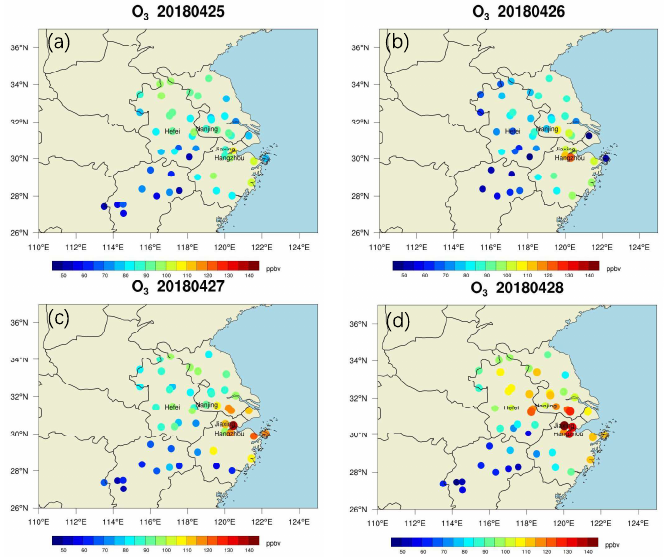
Figure 1. Spacial distribution of ground-level ozone concentration in eastern China, including Jiangsu, Zhejiang, Anhui, Jiangxi provinces and Shanghai, from 25 April 2018 to 28 April